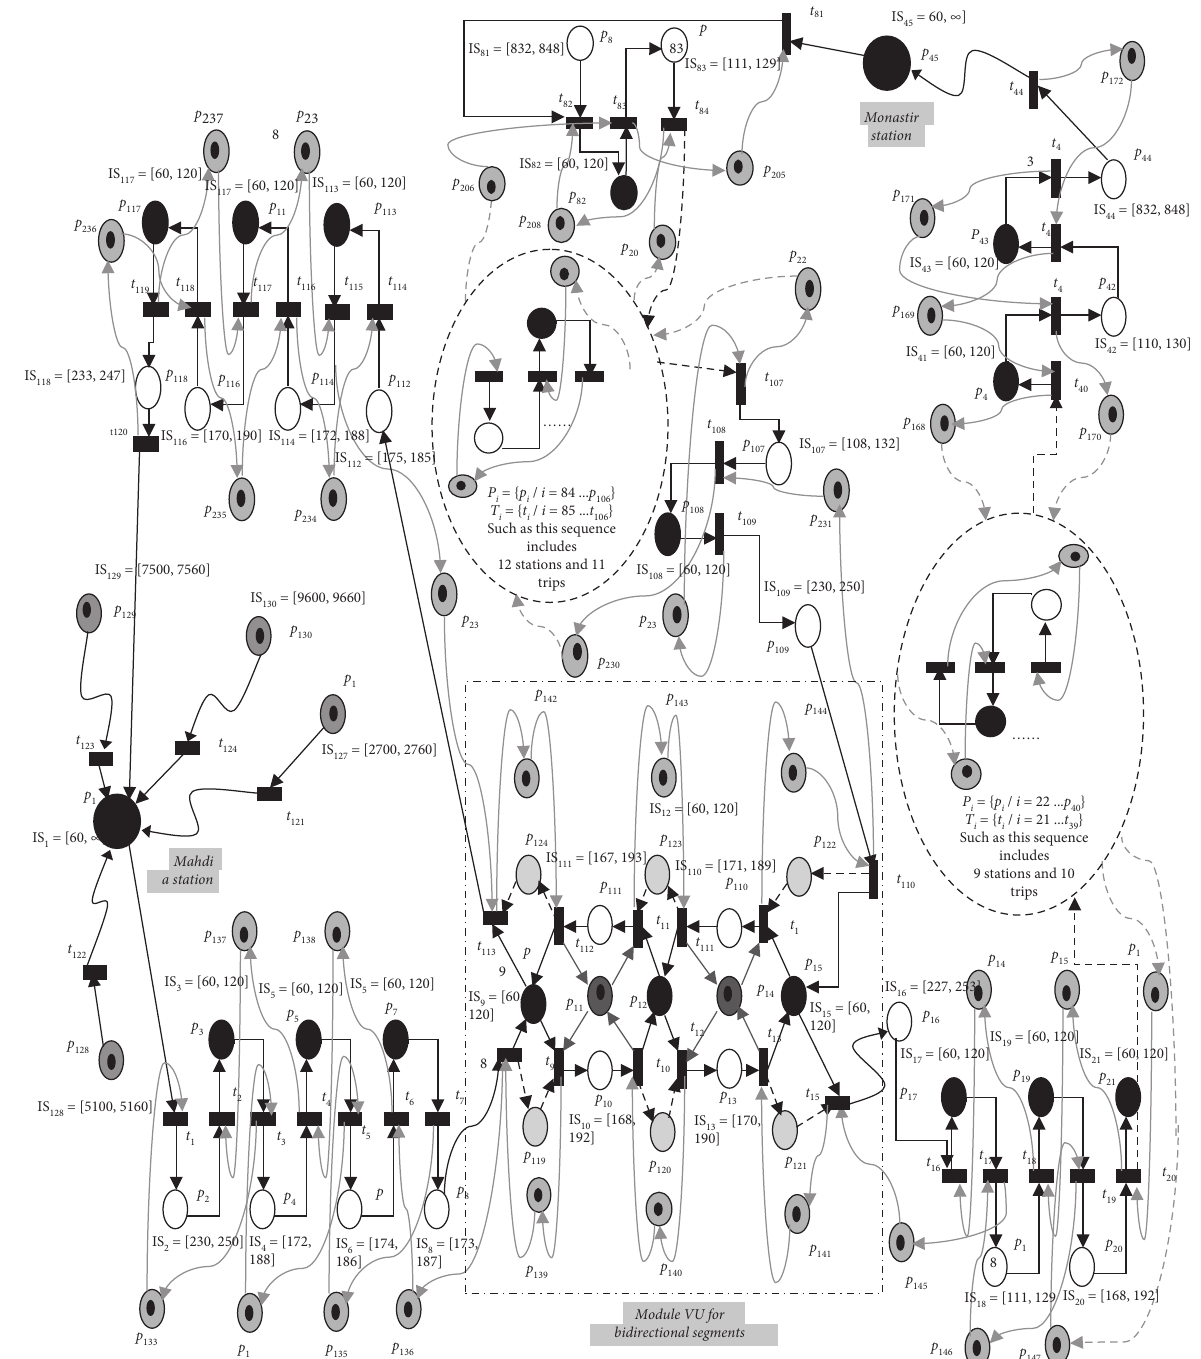
Figure 2: SP-TPN model for the Sahel railway